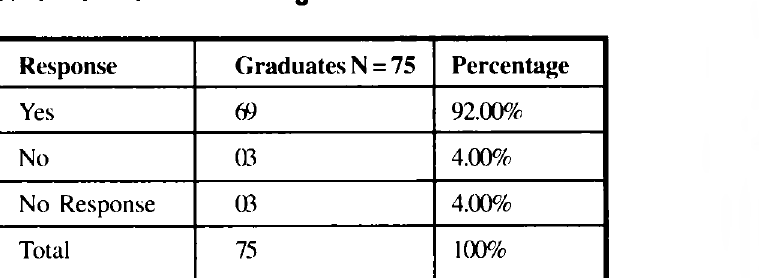
Table 3 - Ability of post-basic programmes to cater for work needs of